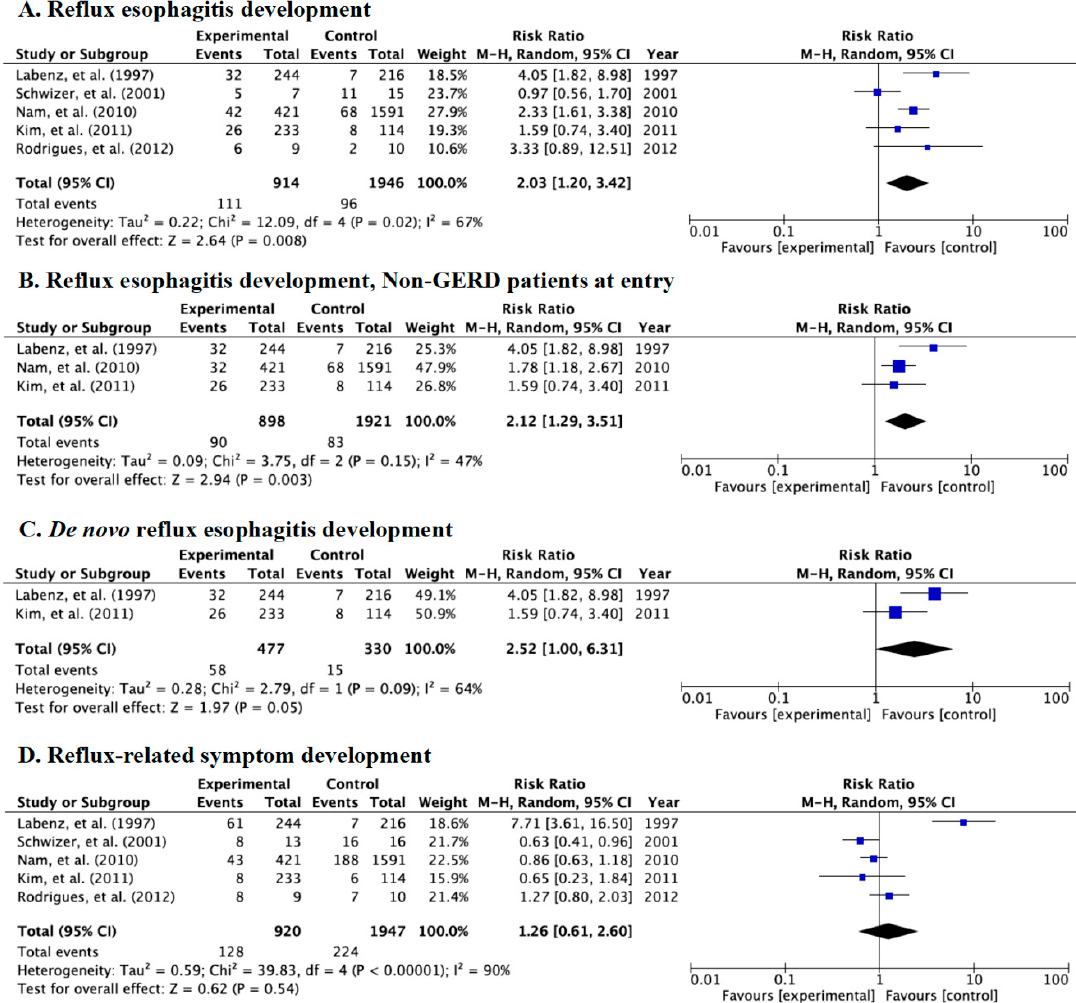
Figure 5. Forest plots of the rate of patients with reflux esophagitis development after eradication irrespective of whether they were free from gastroesophageal reflux disease (GERD) at baseline ( A ), reflux esophagitis after eradication in patients free from GERD at baseline ( B ), the rate of de novo reflux esophagitis newly developed after eradication ( C ), and the rate of patients with reflux-related symptoms after eradication therapy ( D ) in the random-effects model in Category C. Significant differences in reflux esophagitis and de novo esophagitis were shown between patients with successful eradication and the control group. Abbreviations: CI, confidence interval. 95% CI: 0.61–2.60) (Figure